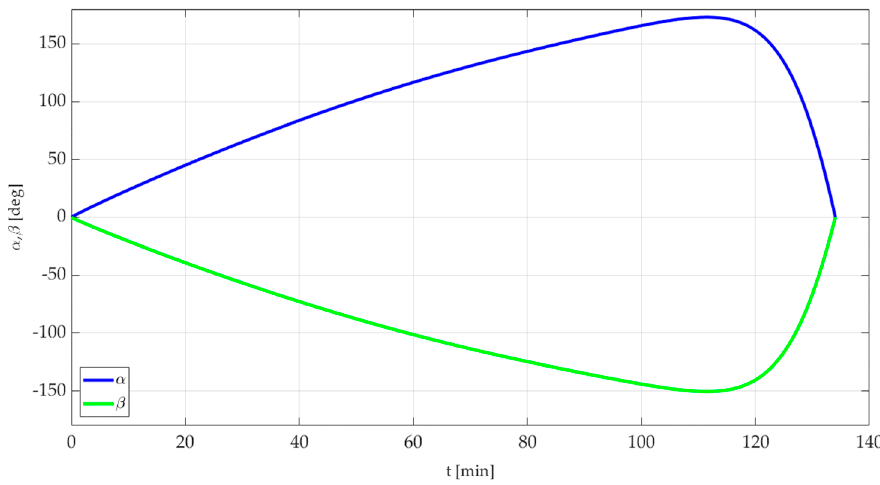
Figure 14. Change in thrust control angles over time (ground-based scenario).